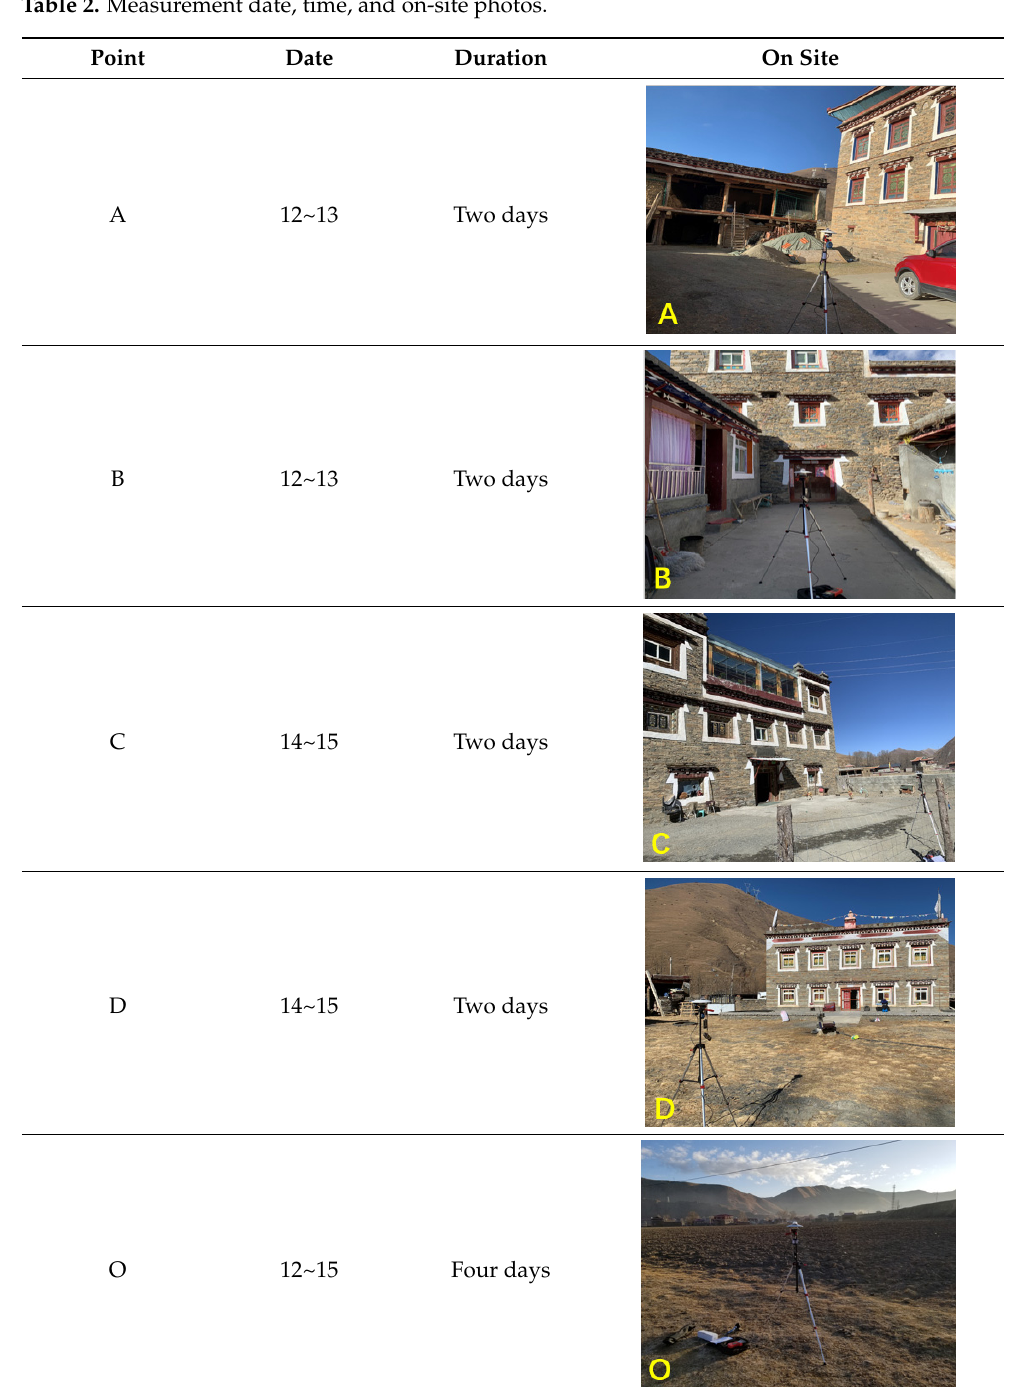
Table 2. Measurement date, time, and on-site photos.